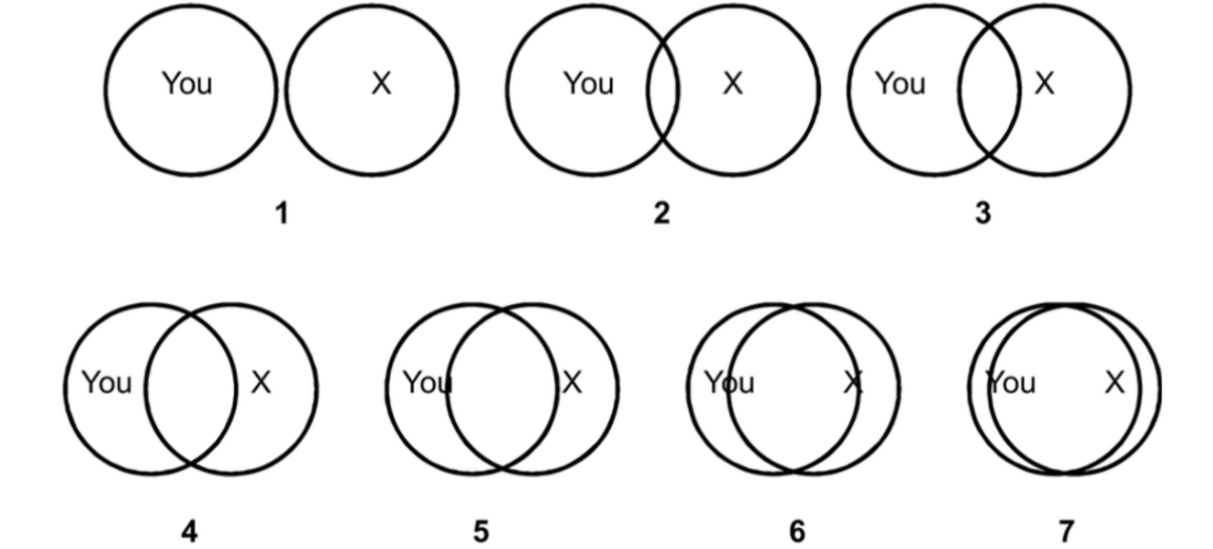
Figure 3. The seven pairs of increasingly overlapping circles describing the relationship between the older users and Anne.